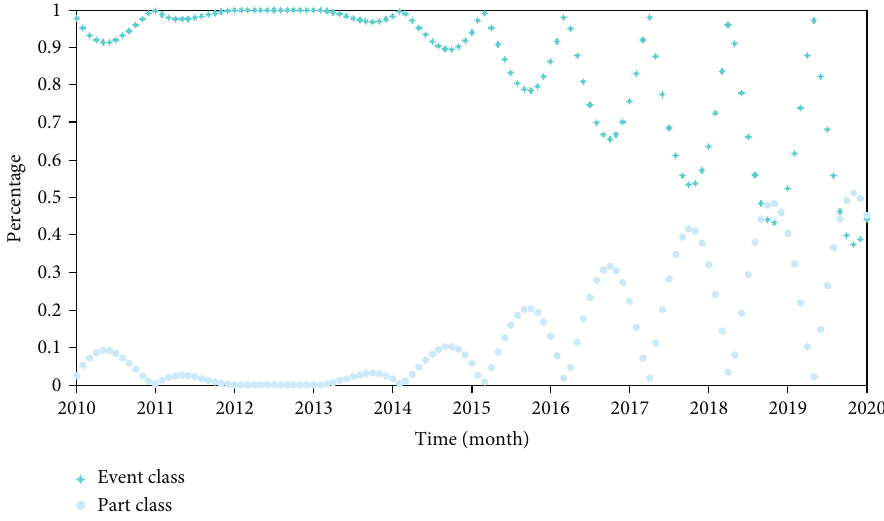
Figure 7: Comparison of simulation of events and components of the big linkage platform.